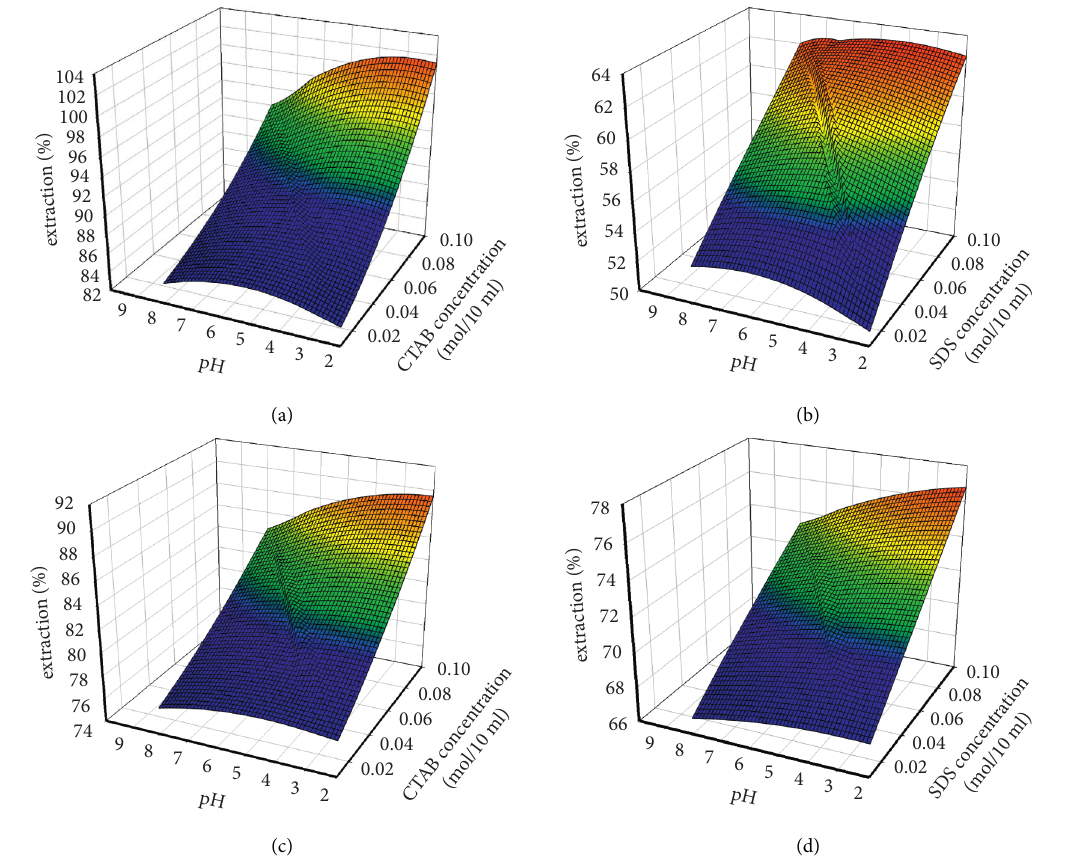
Figure 6: 3D plots of the interaction influence of solution pH and adsorbent dose on the extraction% of RY145 by (a) CTAB and (b) SDS and RB222 by (c) CTAB and (d)